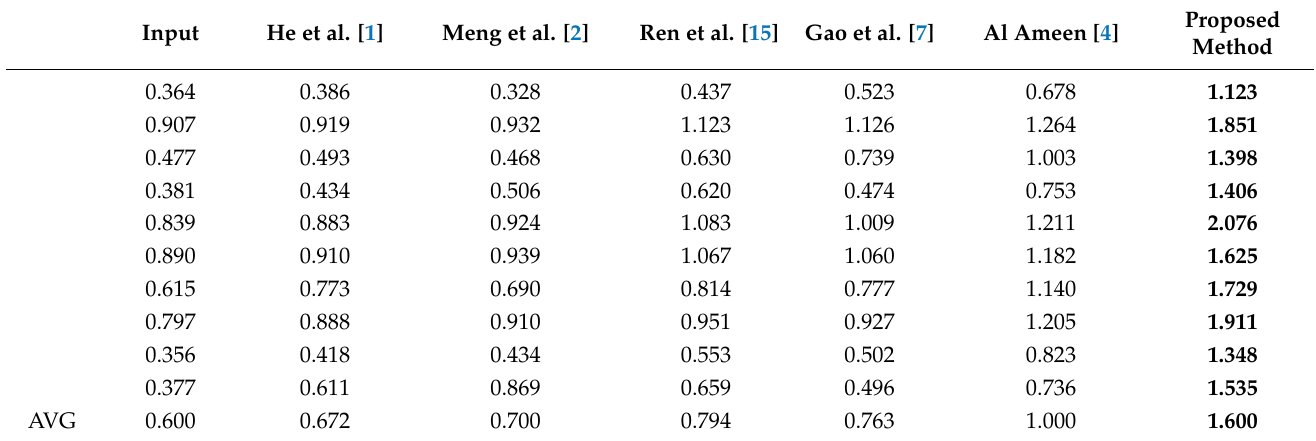
Table 6. The comparison of the UIQM [34] scores from Figure 7 (If the score is high, the image is well enhanced. The highest are indicated in bold ).